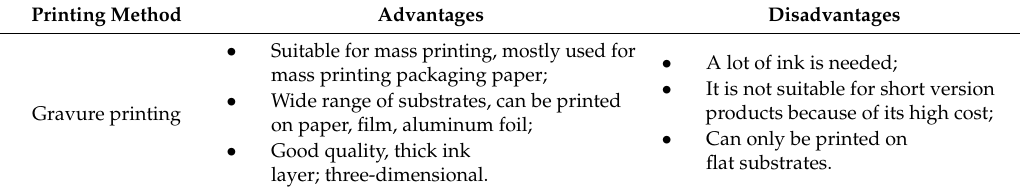
Table 1. Comparing the advantages and disadvantages of gravure printing, screen printing, and inkjet printing.